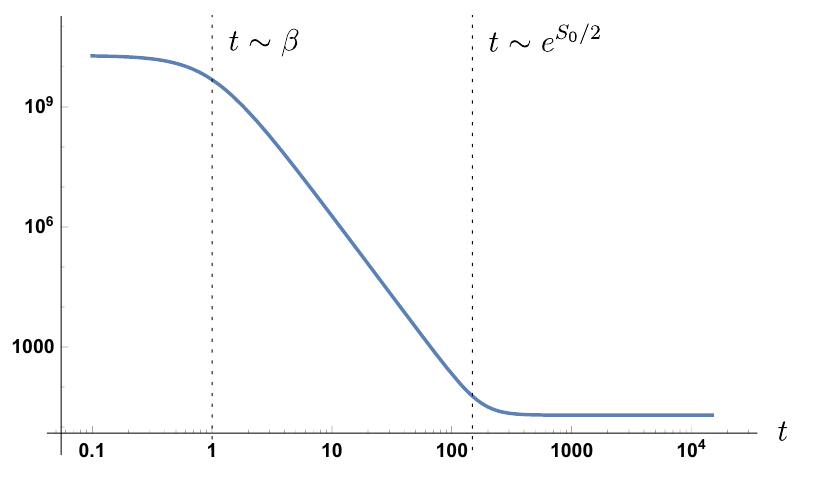
\ CGHS. Plot made with S 0 = 10